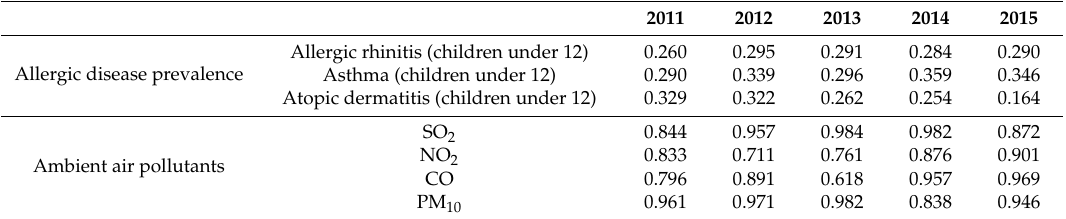
Table 1. Univariate autocorrelation measures of allergic disease prevalence and air pollutants (global Moran’s